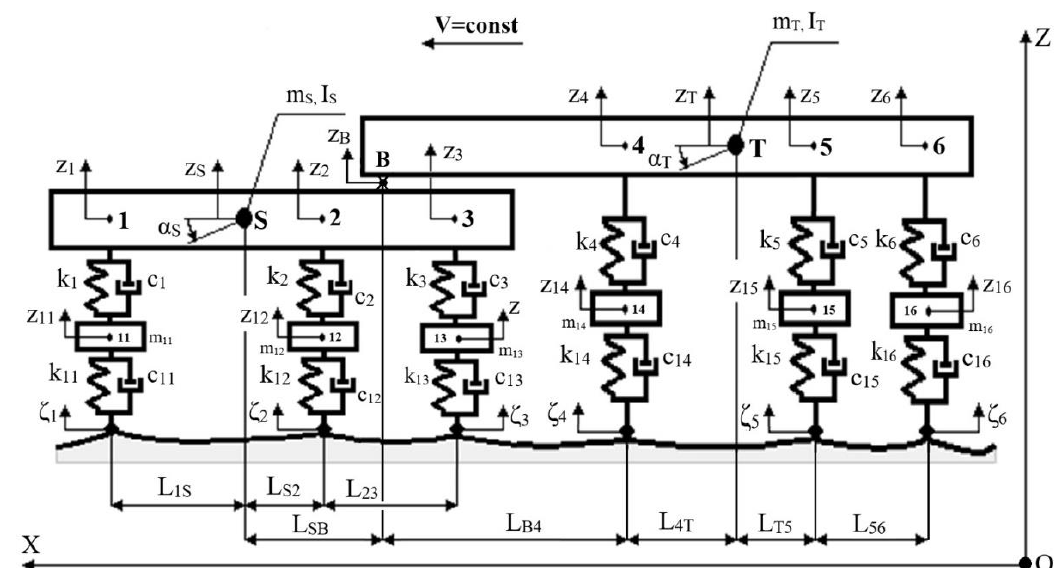
Figure 5. The physical model of the tractor-semitrailer combination in a rectilinear motion with a constant speed V (for descriptions of the model components see the text).